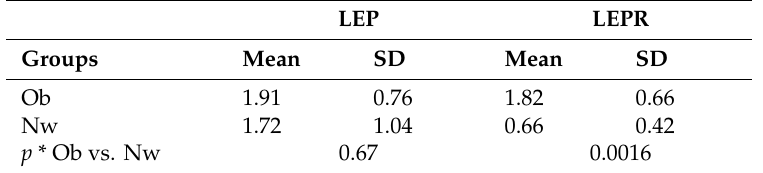
Table 5. Intensity of LEP and LEPR immunostaining in Obese and Normal-weight dog skin sections. LEP LEPR Groups Mean SD Mean SD Ob 1.91 0.76 1.82 0.66 Nw 1.72 1.04 0.66 0.42 p * Ob vs. Nw 0.67 0.0016